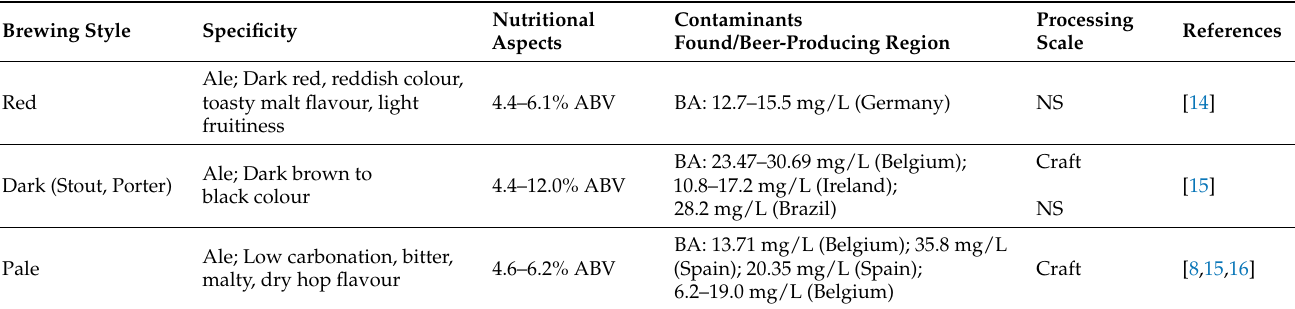
Table 1. Contamination agents reported in beer produced both craft and